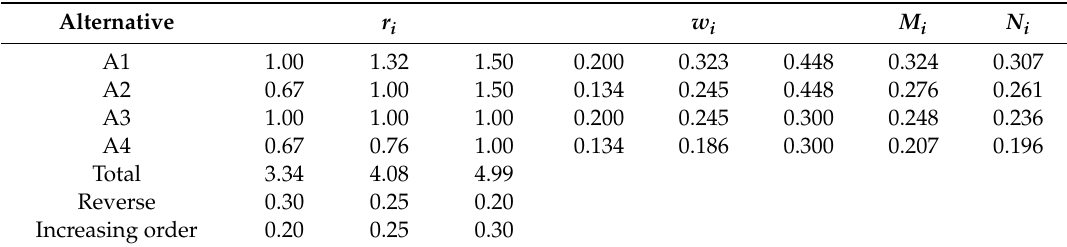
Table 18. Results of r i , W i , M i and N i in respect to the exploitation time.